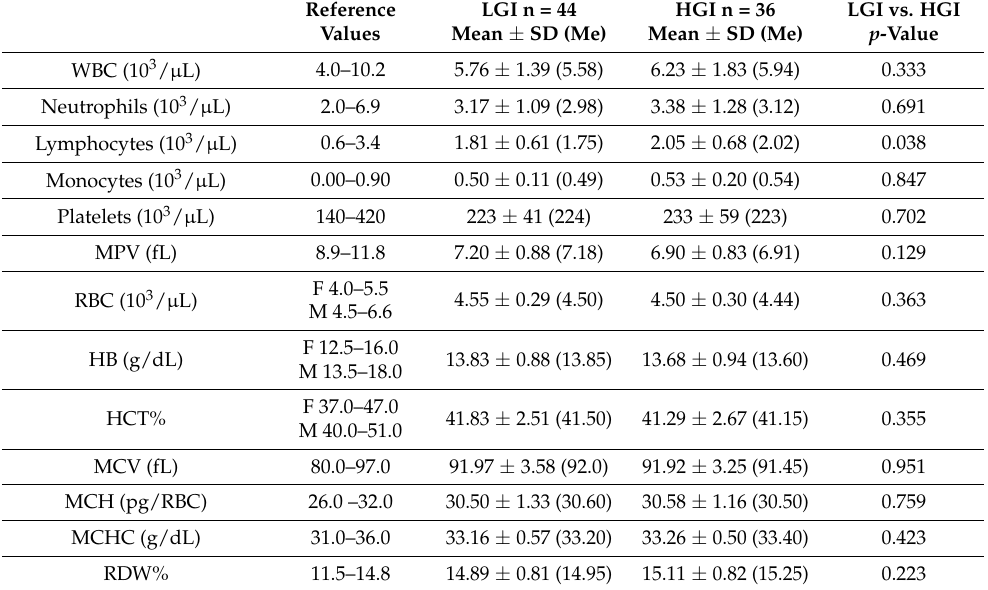
Table 2. Hematological